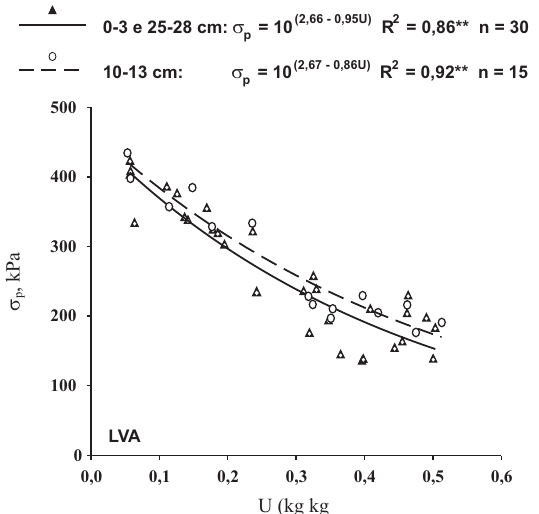
Figura 3. Modelos de capacidade de suporte de carga (CSC) para o sistema de manejo capina manual (CM) no centro da entrelinha, para as camadas de 0–3, 25–28 e 10–13 cm. U: umidade, σσσσσ de preconsolidação.